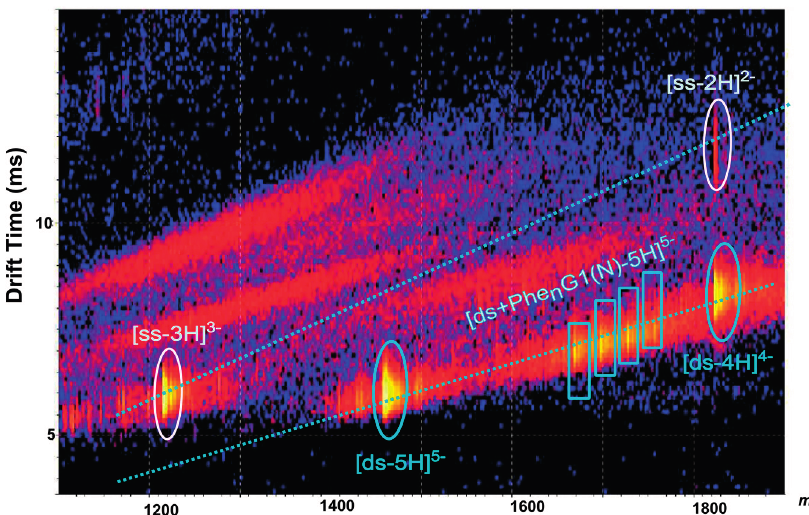
Figure 9. Negative-ion ESI IM-MS plot (drift time vs. m/z ) of [ ds /Phe n G1(N)] dendriplex in 1:10 molar ratio